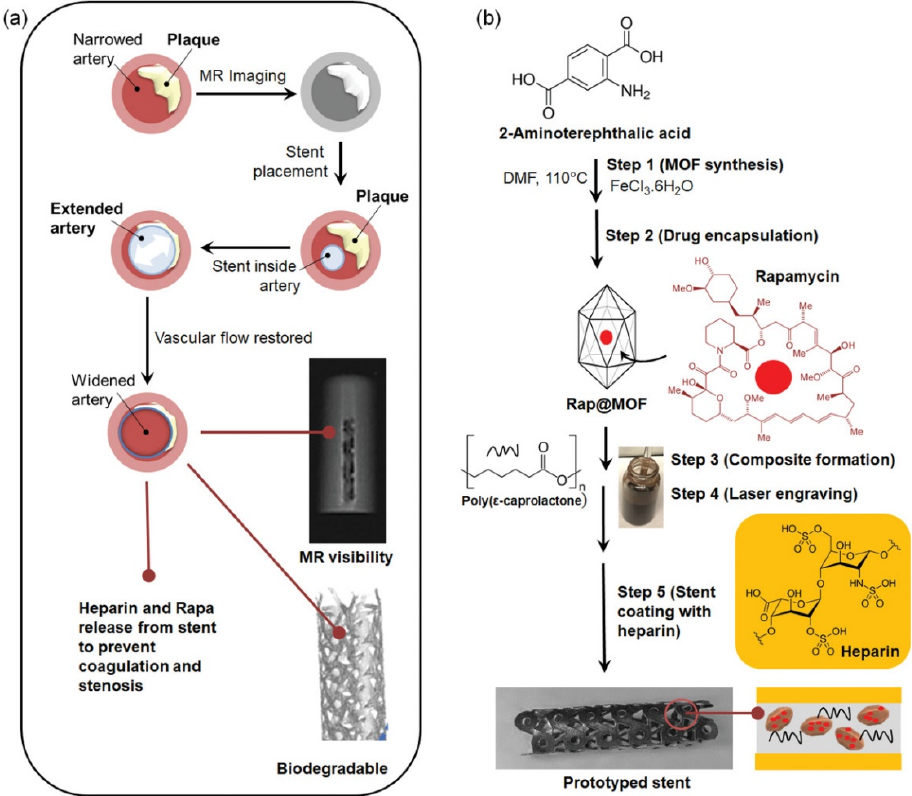
Figure 7. Schematics of MOF-composited polymeric stent: ( a ) Use of MOF-composited polymeric stent to prevent coagulation and stenosis while providing MRI visibility and biodegradability. ( b ) Stepwise process for the development of heparin-coated theranostic MOF-reinforced polymeric stents.